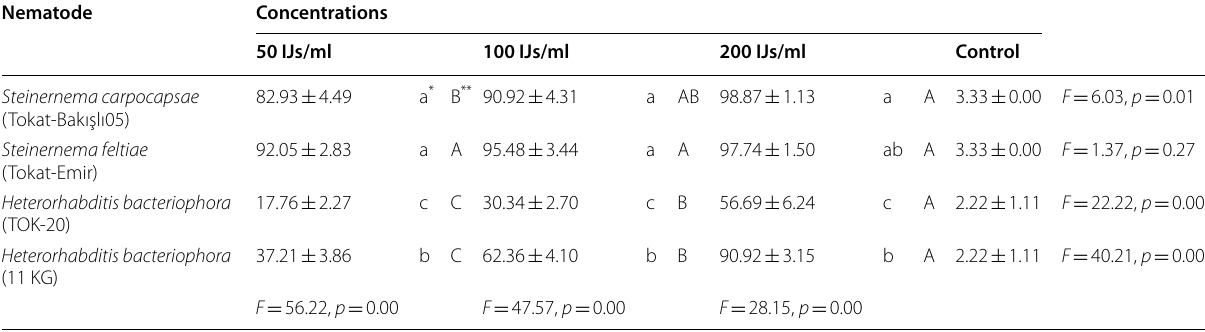
Table 4 Efficacy of nematode isolates and concentrations mortality rate on fourth instar of cotton leafworm larvae